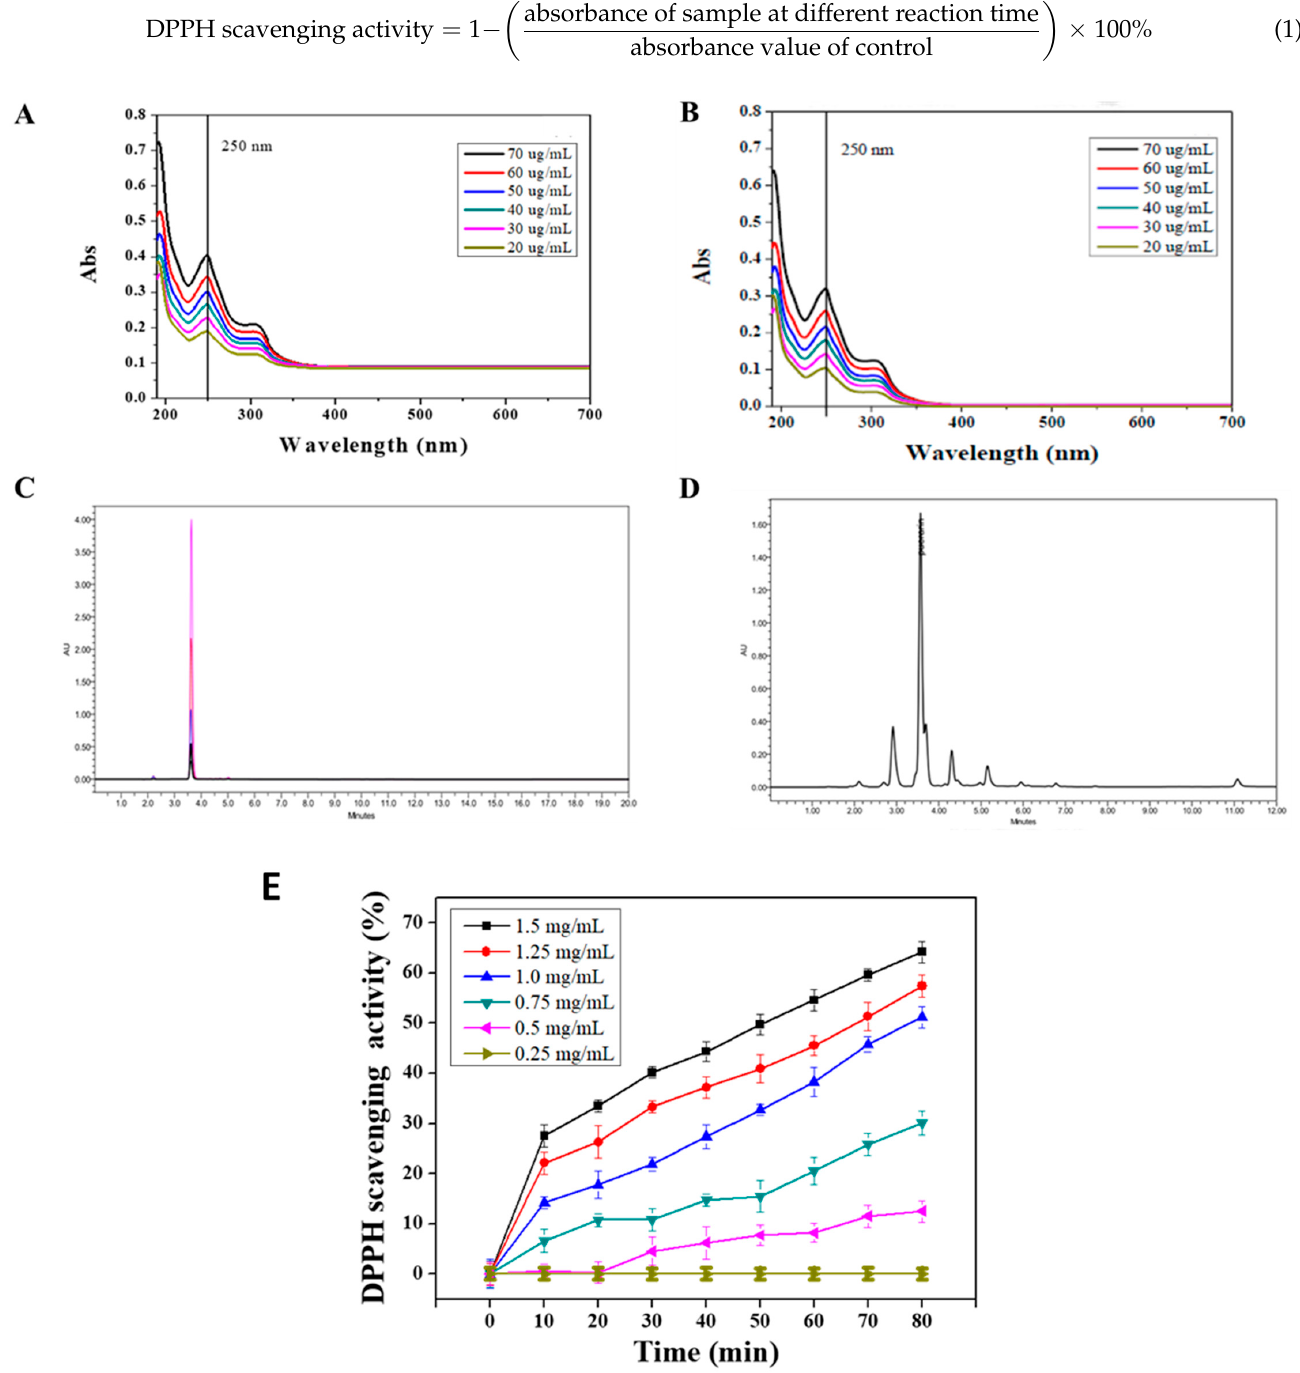
Figure 2. Characterizations of puerarin: ( A , B ) UV/Vis spectra of puerarin standard (CAS number 3681-99-0) and puerarin extract, ( C , D ) HPLC chromatograms of puerarin standard and puerarin extract, and ( E ) DPPH scavenging activity of puerarin extract.